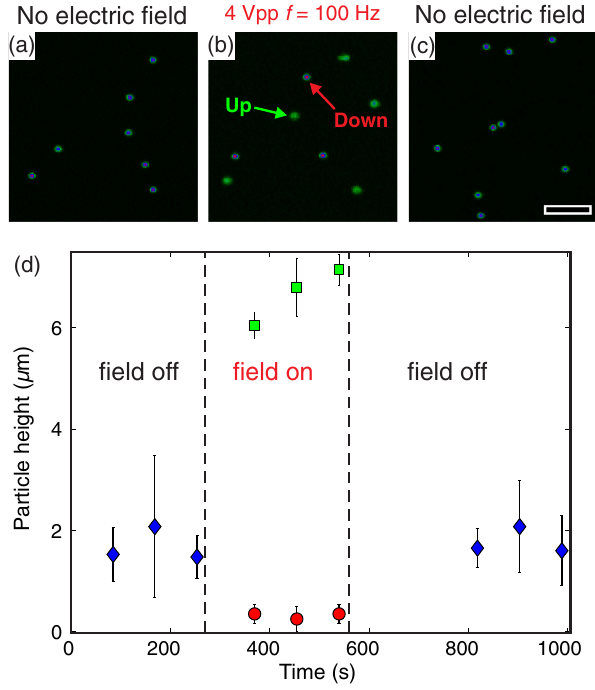
FIG. 2. (a) – (c) Representative false-colored confocal micros- copy images of the height bifurcation exhibited by fluorescent 2 μ m sulfated PS particles in 1 mM NaOH. (a) Prior to application of the field, the particles are all in the same focal plane adjacent to the electrode. (b) 30 s after application of a 4 Vpp, 100 Hz field, the particles have moved to two distinct focal planes. Particles with red centers are approximately in focus, bright green particles are several microns above focus. (c) 5 min after the field is removed, the particles have moved back to their original focal plane. The scale bar in (c) is 10 μ m. (d) Electrode-to-surface particle heights extracted from confocal z scans. Vertical dashed lines indicate when the electric field is applied and removed. For the “ field off ” conditions, the heights are the mean of eight particle heights. For the “ field on ” condition, the heights are the mean of four particle heights in each widely separated focal plane. Error bars are 2 standard deviations around the